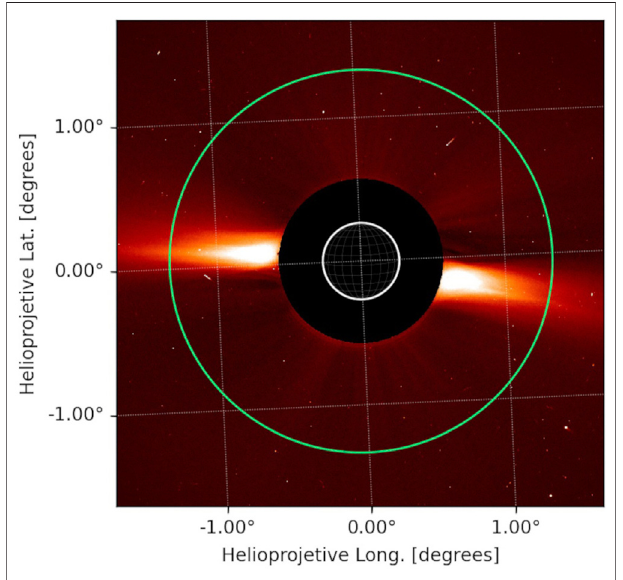
FIGURE1| AprocessedLASCOC2imageonthe2020-10-03at12:00. The green circle depicts the band of pixels that are extracted at 5 . 0 R ⊙ at both East and West limbs to build the synoptic map afterward.